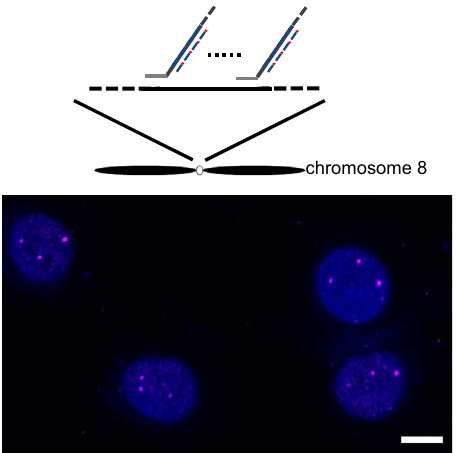
Fig. 3 AmpFISH ef fi ciently labeled interphase chromosomes of HeLa cells using primary ampli fi cation. Most centromeres of HeLa chromosome 8 show three FISH signal puncta. Scale bar: 25 μ